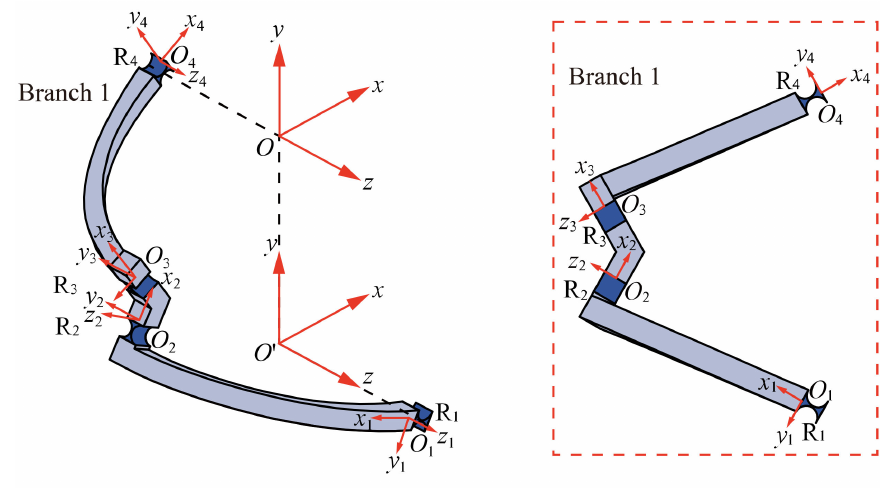
Figure 4. Structure and coordinate frame setting of the branch